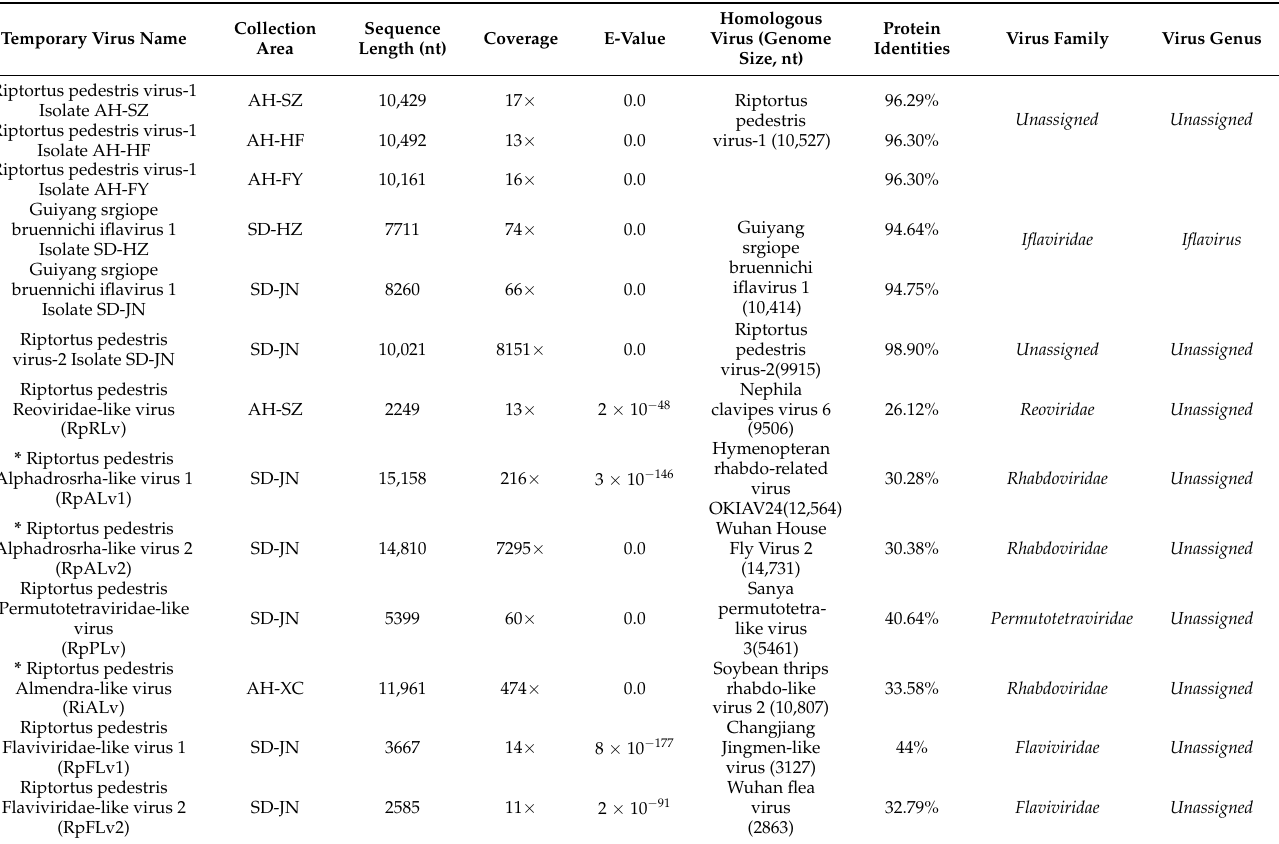
Table 1. Insect-specific viruses identified in R. pedestris